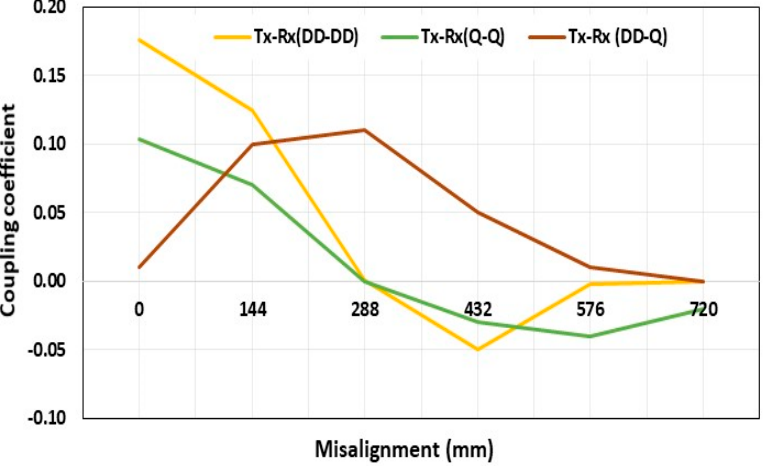
Figure 19. Variation of the coupling coefficient (k) as a function of the misalignment along the y-axis for the DDQ–DDQ configuration.